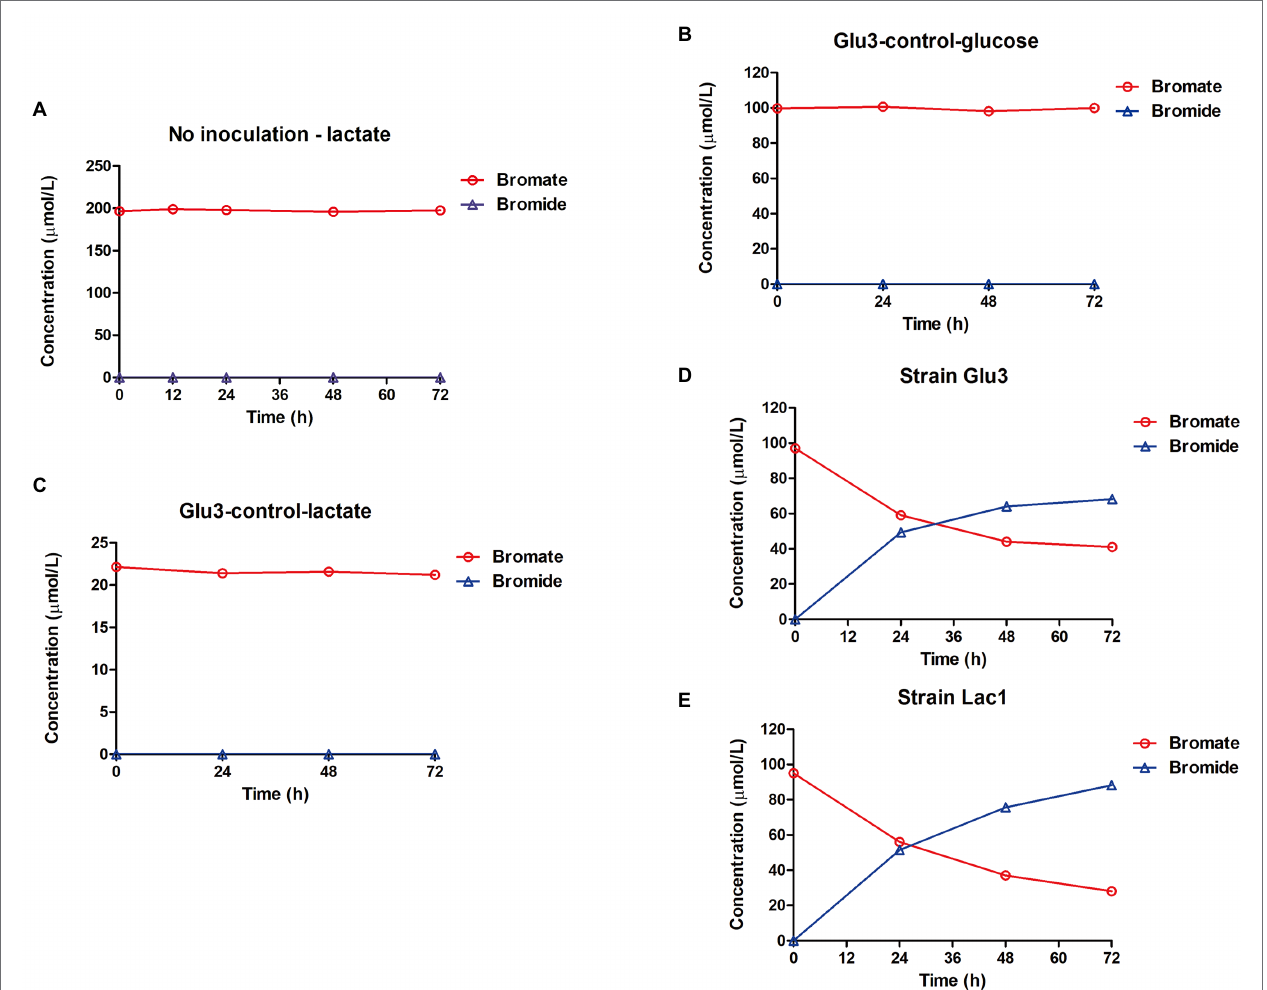
FIGURE 3 | Control experiments showing bromate reduction were due to biological activity. (A) Mineral medium with 1 g/l lactate, 200 μ mol/l bromate, and without inoculation. (B) Heat-killed strain K. variicola Glu3 incubated with 0.5 g/l glucose and 100 μ mol/l bromate. (C) Heat-killed strain K. variicola Glu3 incubated with 0.5 g/l lactate and 20 μ mol/l bromate. (D) Fresh culture of strain K. variicola Glu3 incubated without a carbon source and with 100 μ mol/l bromate. (E) Fresh culture of strain R. electrica Lac1 incubated without a carbon source and with 100 μ mol/l bromate. Error bars represent the estimated standard deviations for duplicate samples and were not visible if less than the size of the